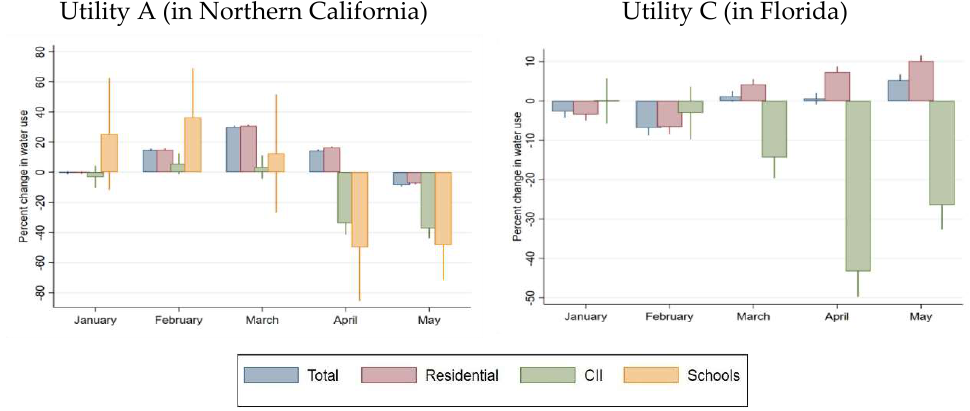
Figure 1. Percent change in monthly water use by category compared with average 2018 and 2019 levels.